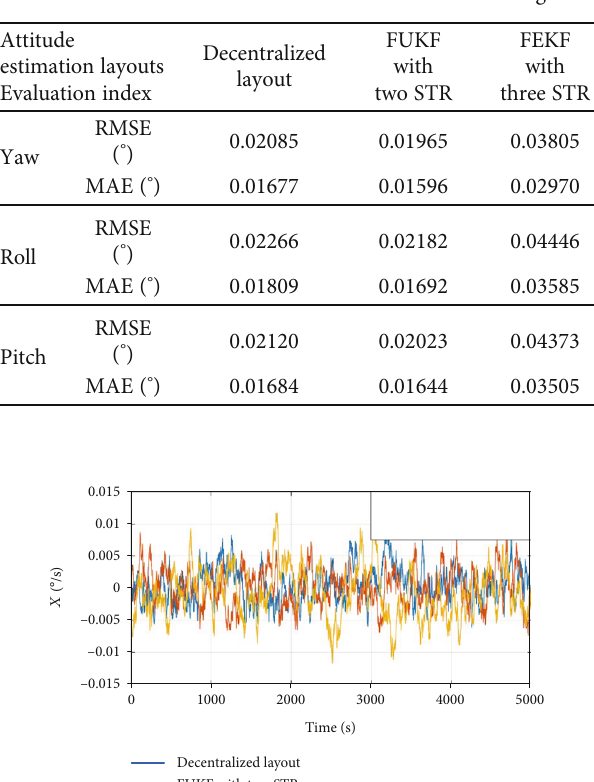
Table 7: RMSE and MAE of estimation error of gyro biases. Table 6: RMSE and MAE of estimation error of Euler